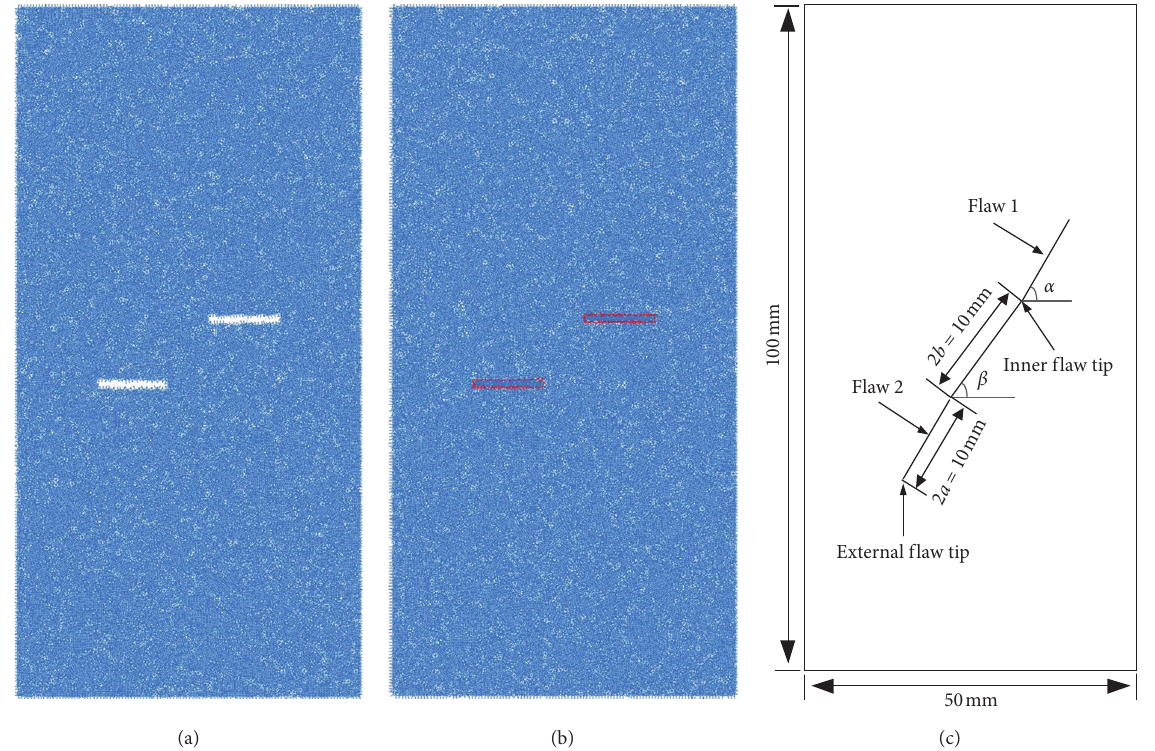
Figure 1: Numerical models used for producing samples with open flaws or infilled flaws (blue line represents parallel-bond contact and the red line represents smooth joint contact). (a) Open flaws. (b) Infilled flaws. (c) Flaw geometry.